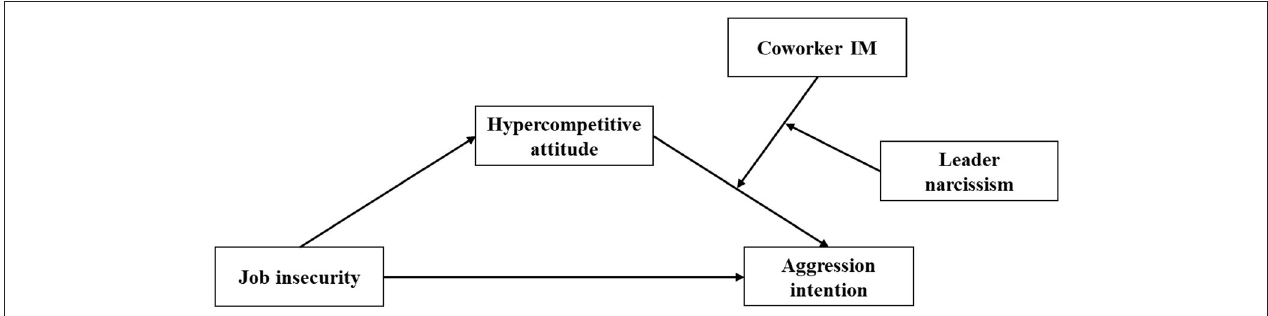
FIGURE 1 | The research